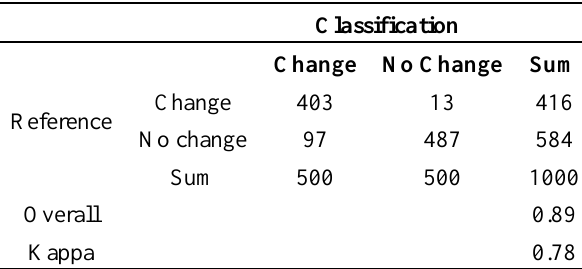
Table 3. The error matrix for change/no-change